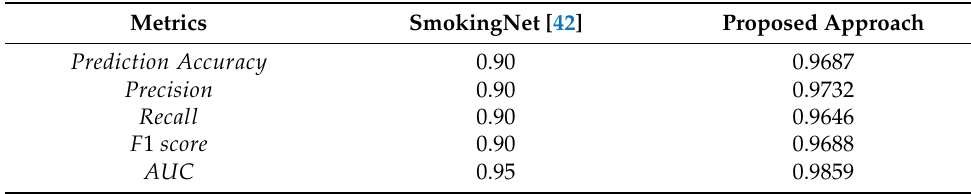
Table 4. Comparative analysis with another smoker classification